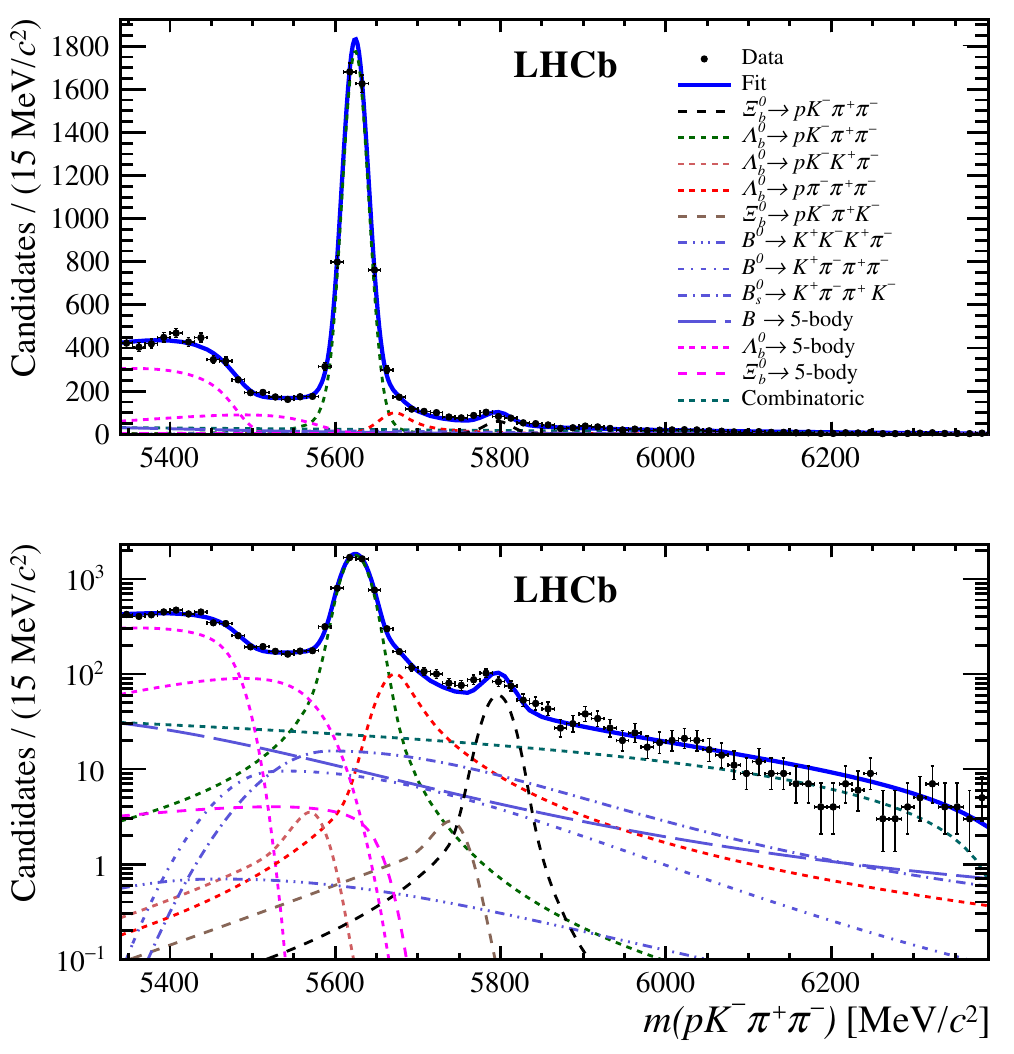
Figure 2 . Results of the (cid:12)t to the pK (cid:0) (cid:25) + (cid:25) (cid:0) candidate mass spectrum with (top) linear and (bottom) logarithmic scales. The di(cid:11)erent components employed in the (cid:12)t are indicated in the legend. The (cid:3) 0 ! 5-body legend describes two components, the radiative partially reconstructed b background (cid:3) 0 ! pK (cid:0) (cid:17) 0 and the partially reconstructed background (cid:3) 0 b (cid:25) 0 is not reconstructed. The latter has a lower-mass